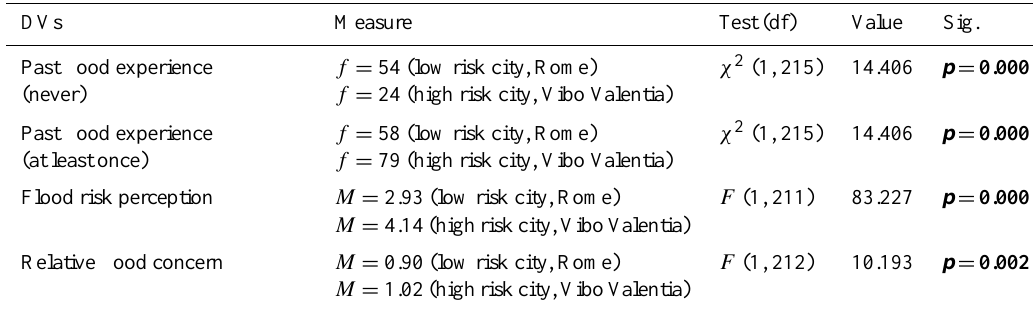
Table A2. URFlood survey results – between cities